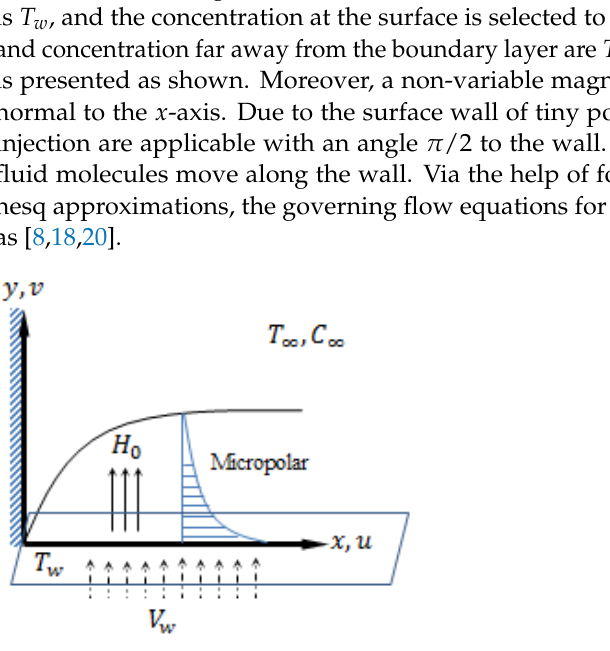
Figure 1. Geometrical coordinates and physical